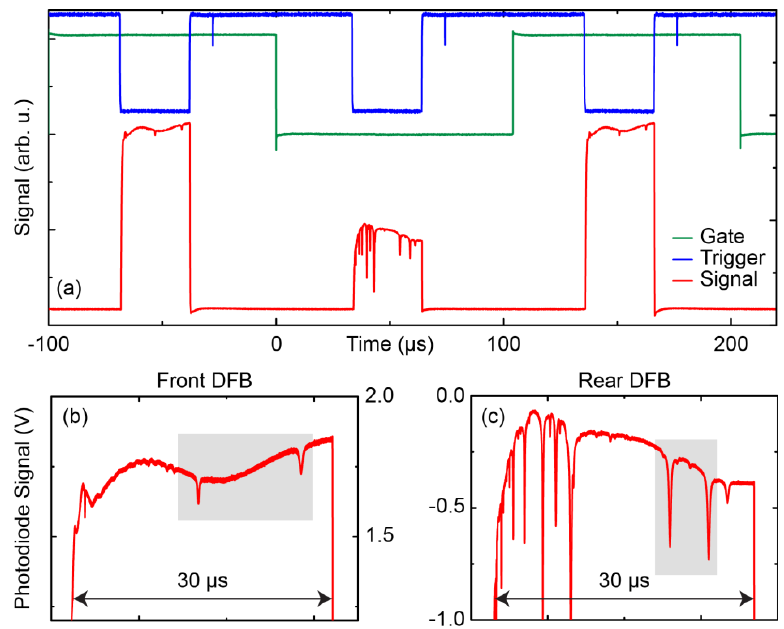
Figure 7. ( a ) Timing scheme of the dual-section DFB QC laser driving. The TTL signals (gate and trigger) are used to alternatively switch between the two sections. The detector signal is also shown (red trace). Lower panel: Close-up of the transmission signals of air sample measured at 50 hPa pressure using a multipass cell with 36 m optical path length; ( b ) Front DFB for N 2 O and CO; ( c ) Rear DFB (CO 2 ) isotopologues. The regions used for the concentration measurements are highlighted in